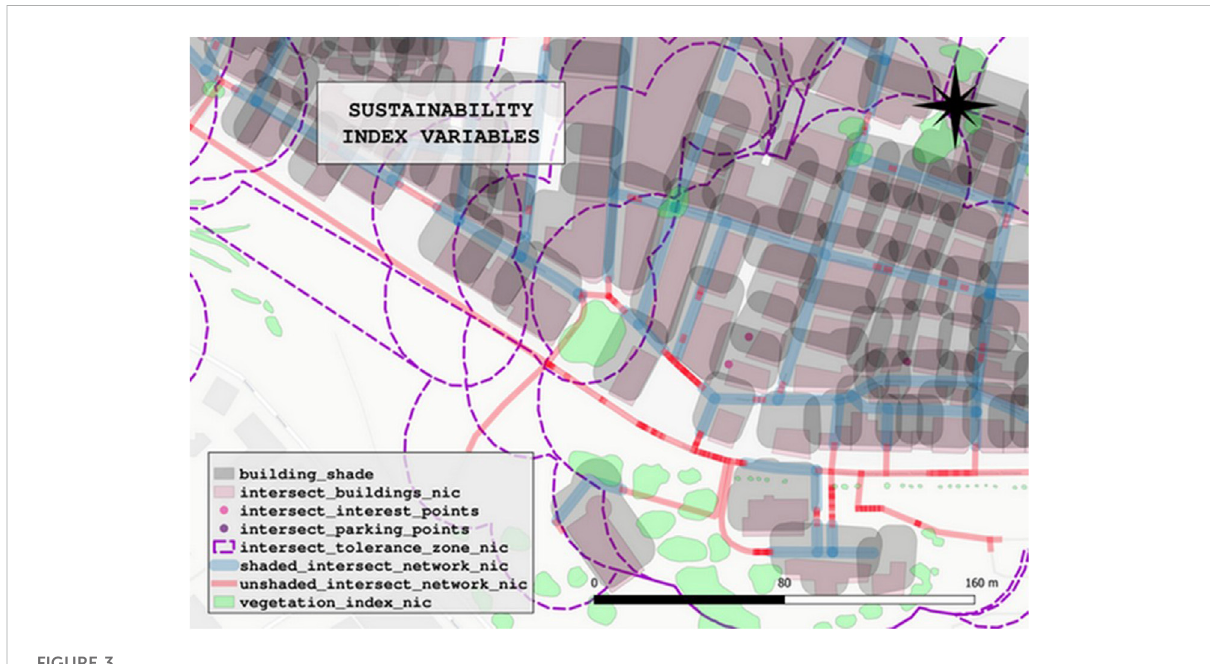
FIGURE 3 Intermodal walkability index